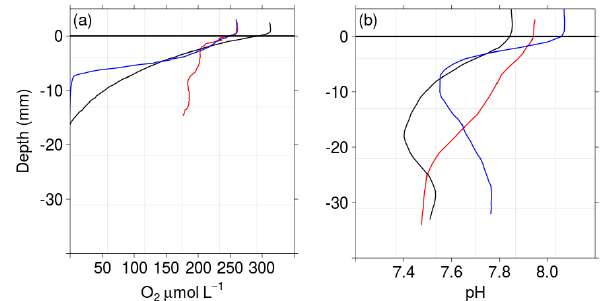
Figure 5. Examples of microsensor depth profiles from different re- gions of the North Sea. (a) O 2 ; (b) pH; red: Station 11 (SNS); blue: Station 65 (SKNT); black: Station 80 (NNS); solid line: sediment– water